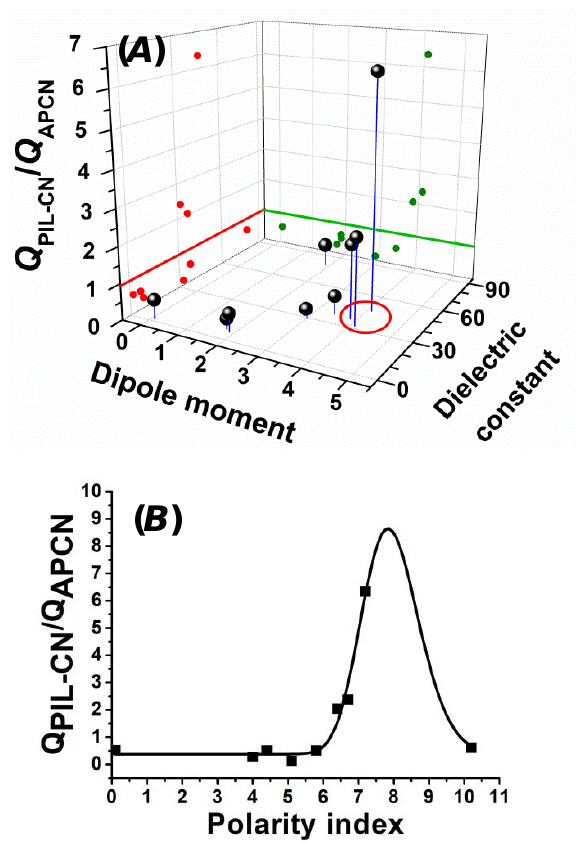
Figure 8. The ratio of the equilibrium swelling degrees of the PVImMe -l- PTHF-57 poly(ionic liquid) conetwork (Q PIL-CN ) and the PVIm -l- PTHF-57 (Q APCN ) conetwork as a function of the dipole moment